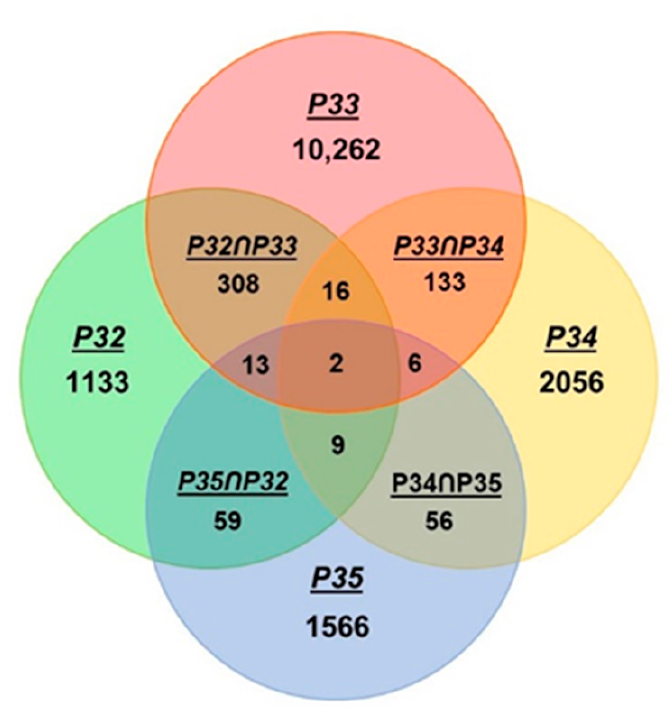
Figure 3. Combinatorial locations of Pro residues in PPR. The occurrence of Pro at the distal end of PPR was counted by Excel’s ‘countif’ function as described in Results (Section 2.1.4). Colocalizations of Pro at multiple sites were also counted similarly and the numbers presented in the overlapping areas of the Euler diagram (which may appear similar to the more commonly known ‘Venn diagram’). Results confirm that position 33 indeed takes the lion’s share of Pro in this area (10262), compared to the second highest number (2056) at 34, but a considerable number of di-Pro (PP) were also noted, as shown in the intersections. The most abundant were P32 ∩ P33 (308), followed by P33 ∩ P34 (133), evidently contributed by the common P33. A smaller number of tri-Pro (PPP) were found as well, and the most abundant ones contained P33 at the center, i.e., P32-33-34 (16). Proline quadruplet (P32-33-34-35) was practically nonexistent in PPR and occurred only twice in our 26333-strong cohort; they were the last two PPR units of a 16-PPR soybean protein (K7MEB5) and were essentially identical in sequence (34 out of 35 resides were identical). To conclude, Pro33 appears to be the most crucial helix-terminating residue in PPR, functionally equivalent to P23 of TPR, and the neighboring Pro residues likely played accessory roles to various